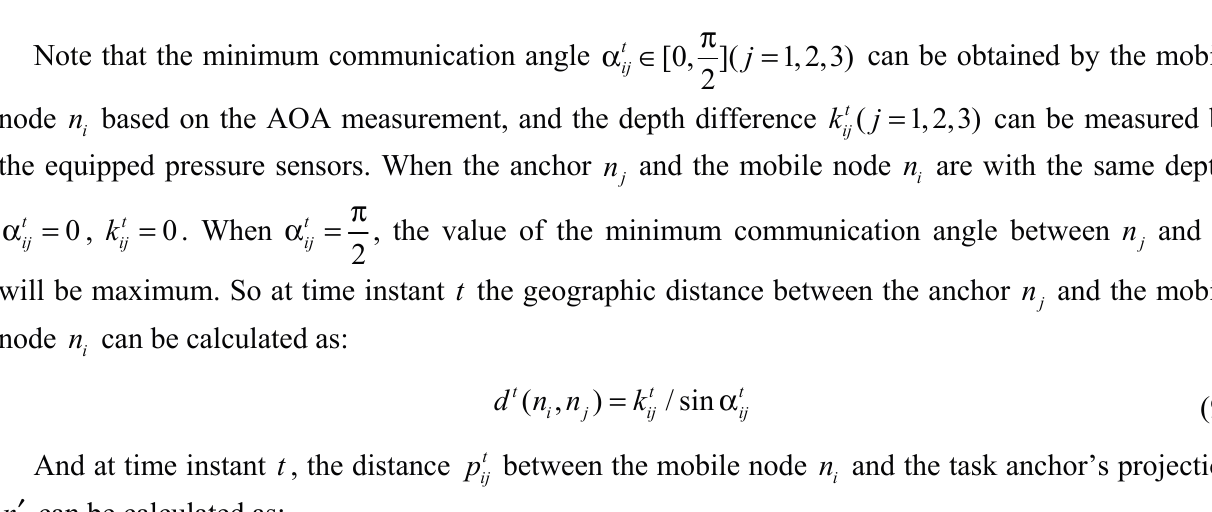
Figure 2. Hierarchical and projection structure